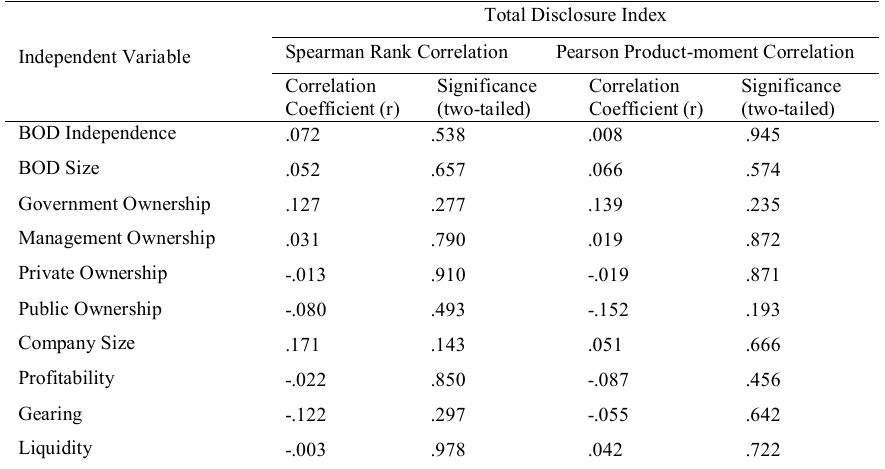
Table 3. Correlation between Total Disclosure Index and Continuous Independent